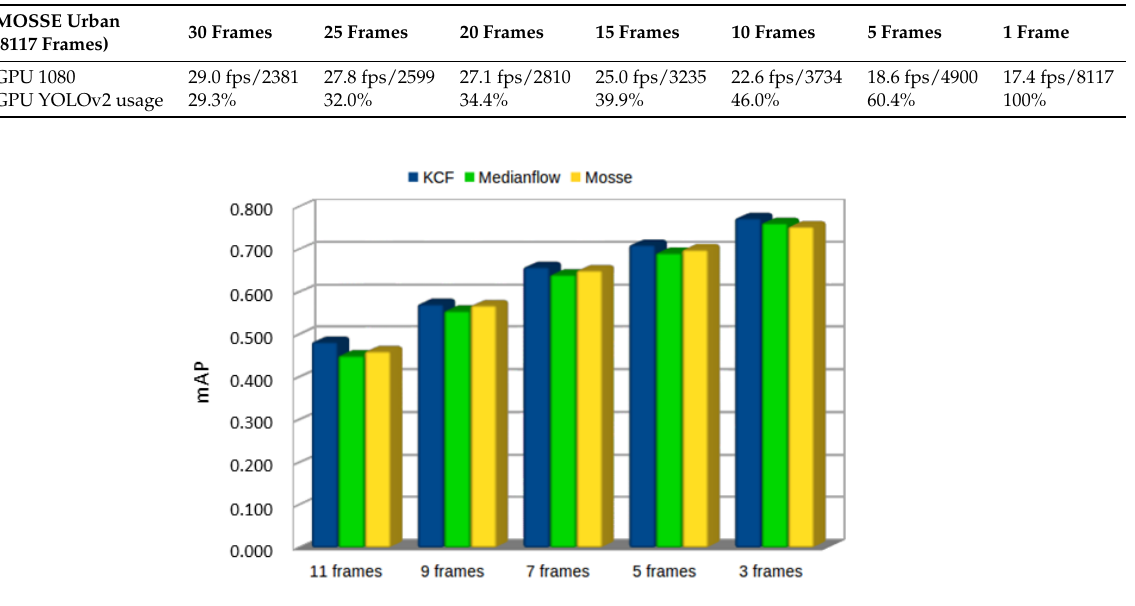
Table 3. YOLOv2 + Mosse tracker performance every n frames in an urban environment video. YOLO detection is performed every n frames, starting with n = 30 and ending with n = 1 (tracking disabled). We can see how, as we perform tracking for a larger number of frames, for example n = 25, the overall performance increases, with it being able to process video at 27.8 fps.